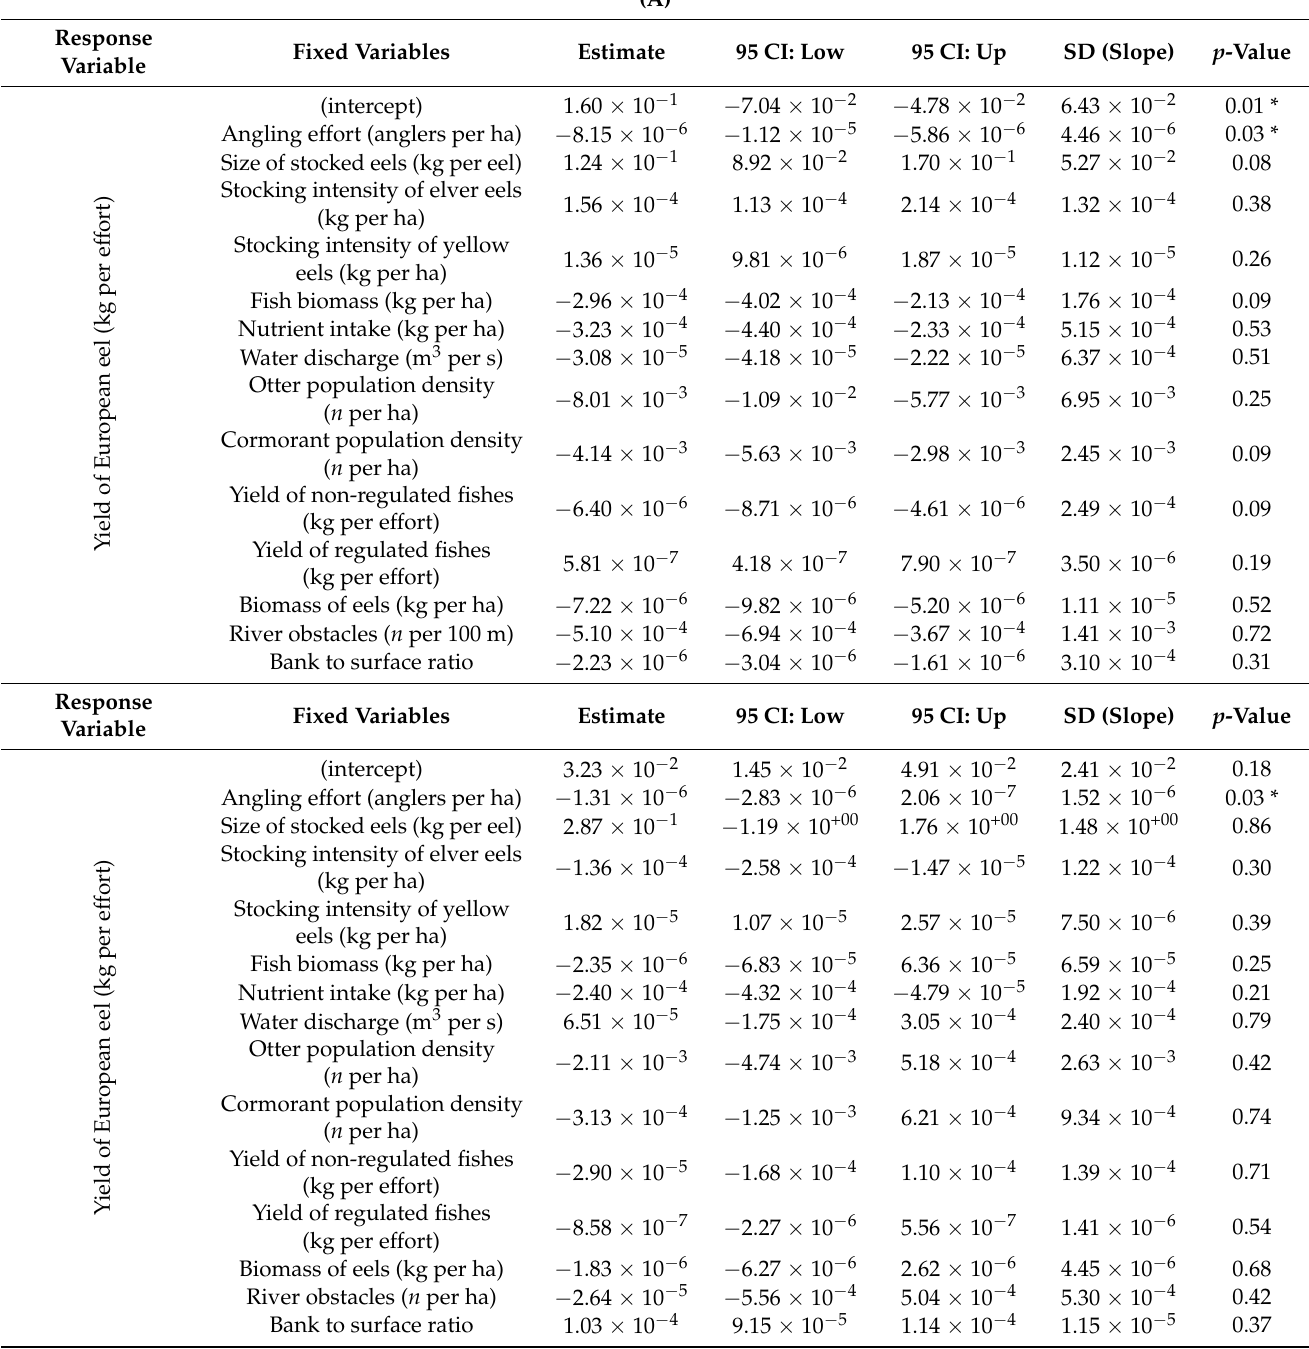
Table 3. The correlations between the yield of the European eel Anguilla anguilla and the studied fishery parameters. The data are ( A ) prior and ( B ) after increasing the legal angling size of the European eel from 45 cm to 50 cm TL. The data were collected by the Czech Fishing Union on 176 studied and 25 control river stretches over the years 2005–2018. They originate from angling logbooks that were submitted by recreational